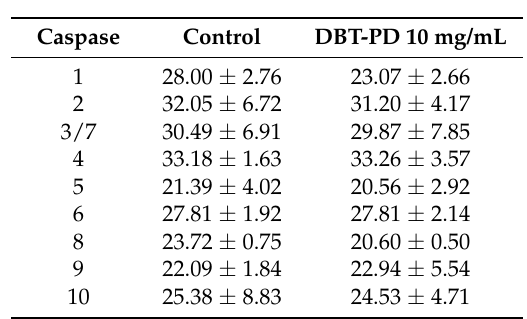
Table 3. Caspase activity measurement in CT26 cells treated with DBT-PD.